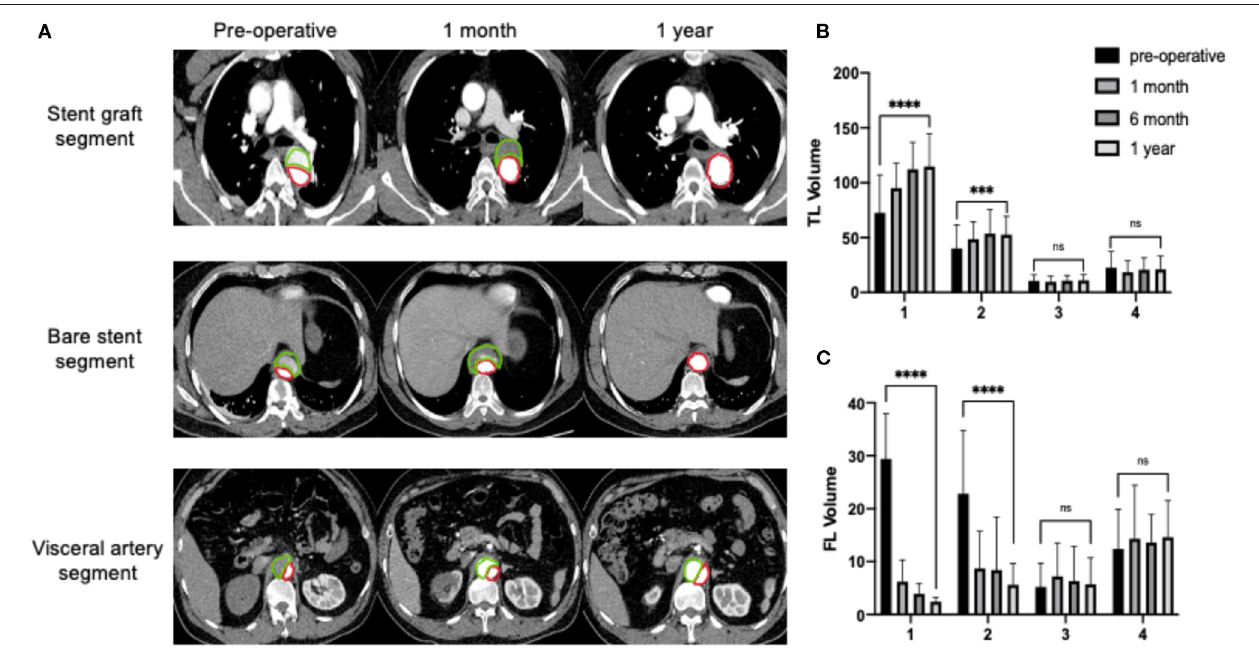
FIGURE 2 | Continuous process of aortic remodeling with an expanding TL and shrinking FL after the implantation of the Fabulous stent system. Segment 1: the opening of LSA to the distal end of SG; Segment 2: the distal end of the SG to the opening of the celiac trunk and containing the segment covered by bare stent; Segment 3: the opening of celiac trunk to the lower renal artery; Segment 4: the lower renal artery to the bifurcation. (A) The true lumen (TL, red) gradually expanded and the false lumen (FL, green) gradually shrank. (B) The volume of the TL (cm3) continuously increased in segments covered by stent grafts and bare stents, and reached a relative high level at 6th month and reached a stable level at 1 year. The uncovered segments didn’t show the trend of negative remodeling. (C) The volume of FL (cm3) decreased significantly in segments covered by stent graft and bare stent. No increase in volume of the uncovered FL. *** P < 0.001; **** P <